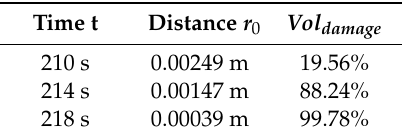
Table 7. The irreversible thermal damage of lipoma tumor at a voltage V =